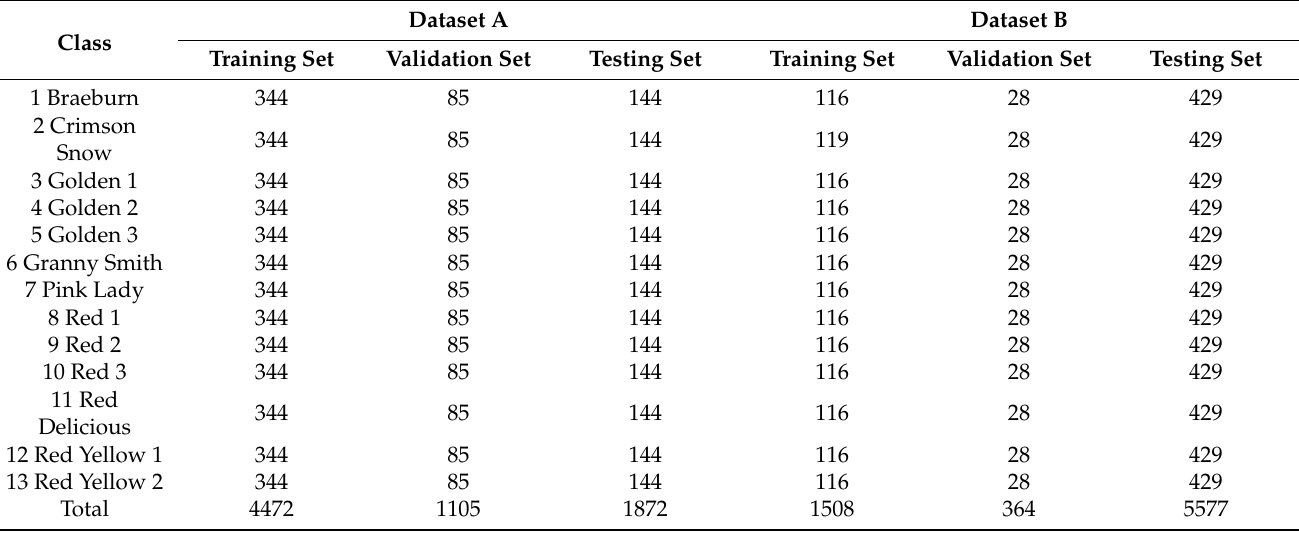
Table 1. The number of images per class for training, validation, and testing in the two